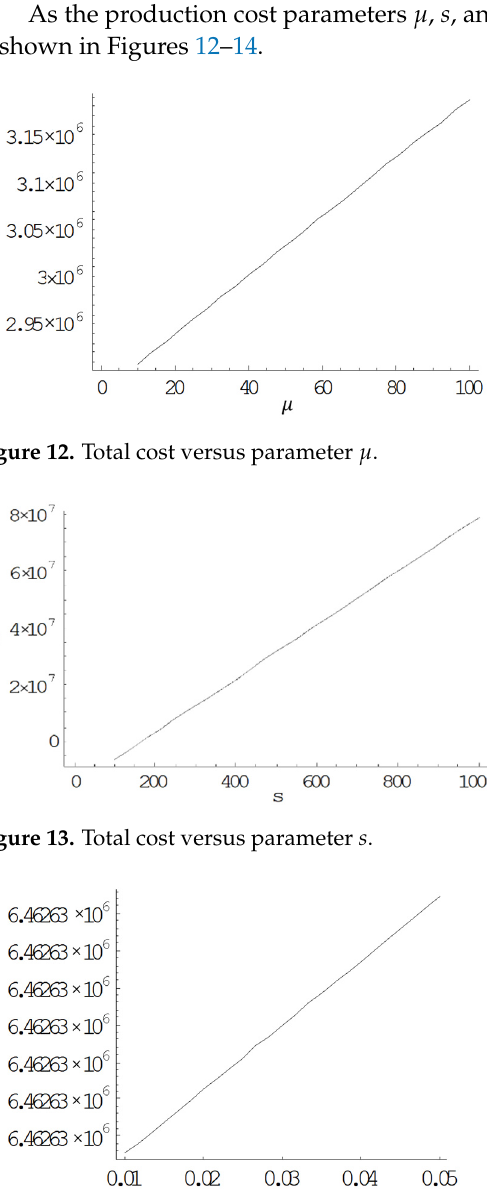
Figure 11. Total cost versus parameter β .